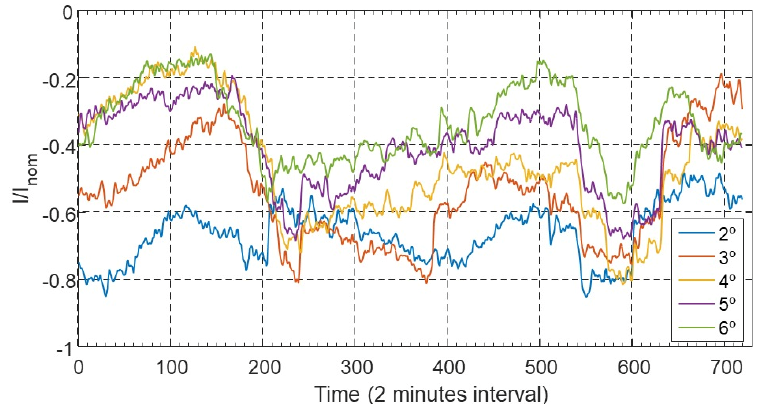
Figure 25. Second week of February: evolution of load factor for different working days (2nd to 6th), presenting a similar pattern as the first week.